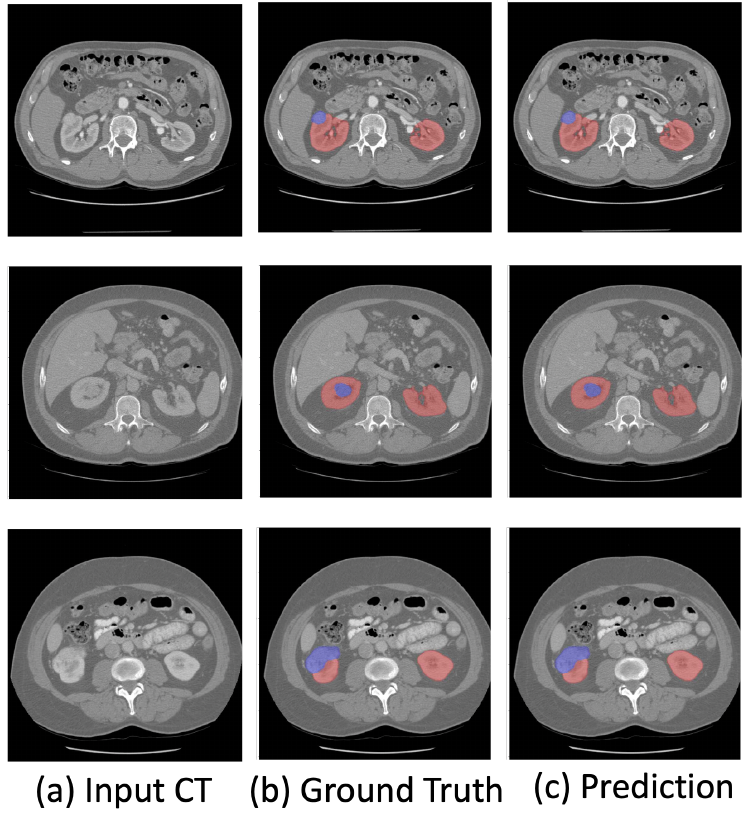
Figure 2. Visualization of the predicted kidney (red) and renal mass (blue)